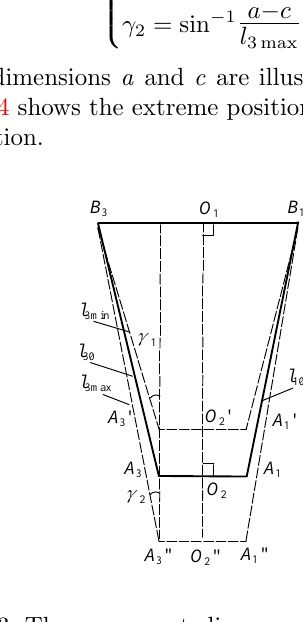
Figure 3: The movement diagram of the MP along z direction, with extreme positions displayed in dashed lines